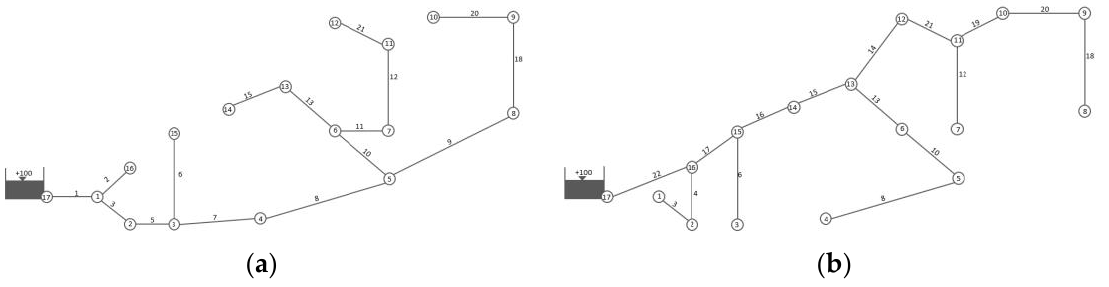
Figure 3. Schematic of pair of backups: ( a ) The first subsystem generated following decreasing order; ( b ) The second subsystem generated following increasing order.